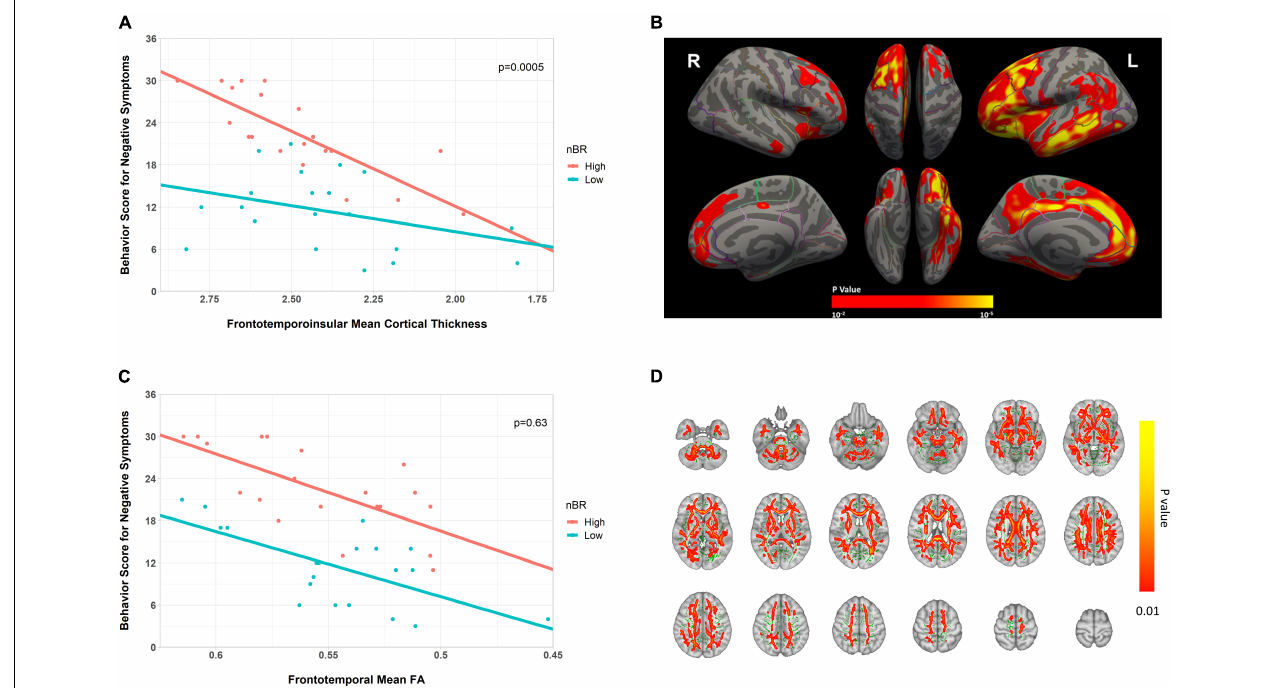
FIGURE 5 | Scatter plot for the interaction of the behavioral reserve marker for negative symptoms (nBR) and the neuroimaging abnormalities (cortical thickness and FA) on behavioral score for negative symptoms in bvFTD. (A,C) Scatter plots for the interaction of the nBR with (A) fronto-temporo-insular mean cortical thickness and (C) frontotemporal WM FA on behavioral score for negative symptoms in bvFTD. For illustration, groups with high and low nBR markers (defined using the median value) are plotted separately. (B) Cortical thickness-related nBR, adjusted for the age and sex ( p < 0.01; corrected at the cluster level at p < 0.01). (D) FA-related nBR (in red-yellow), adjusted for the age and sex, and the mean FA skeleton (in green, FA 0.2). The results are corrected by threshold-free cluster enhancement and 10,000 permutations. Cluster significance was tested at p < 0.01 and subjected to multiple corrections. nBR, behavioral reserve for negative symptoms; FA, fractional anisotropy; bvFTD, behavioral variant frontotemporal